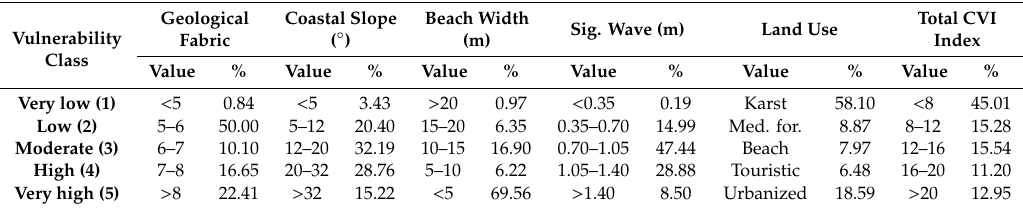
Table 3. The relative vulnerability variable in the relationship to defined vulnerability categories for the analyzed parameters and the total